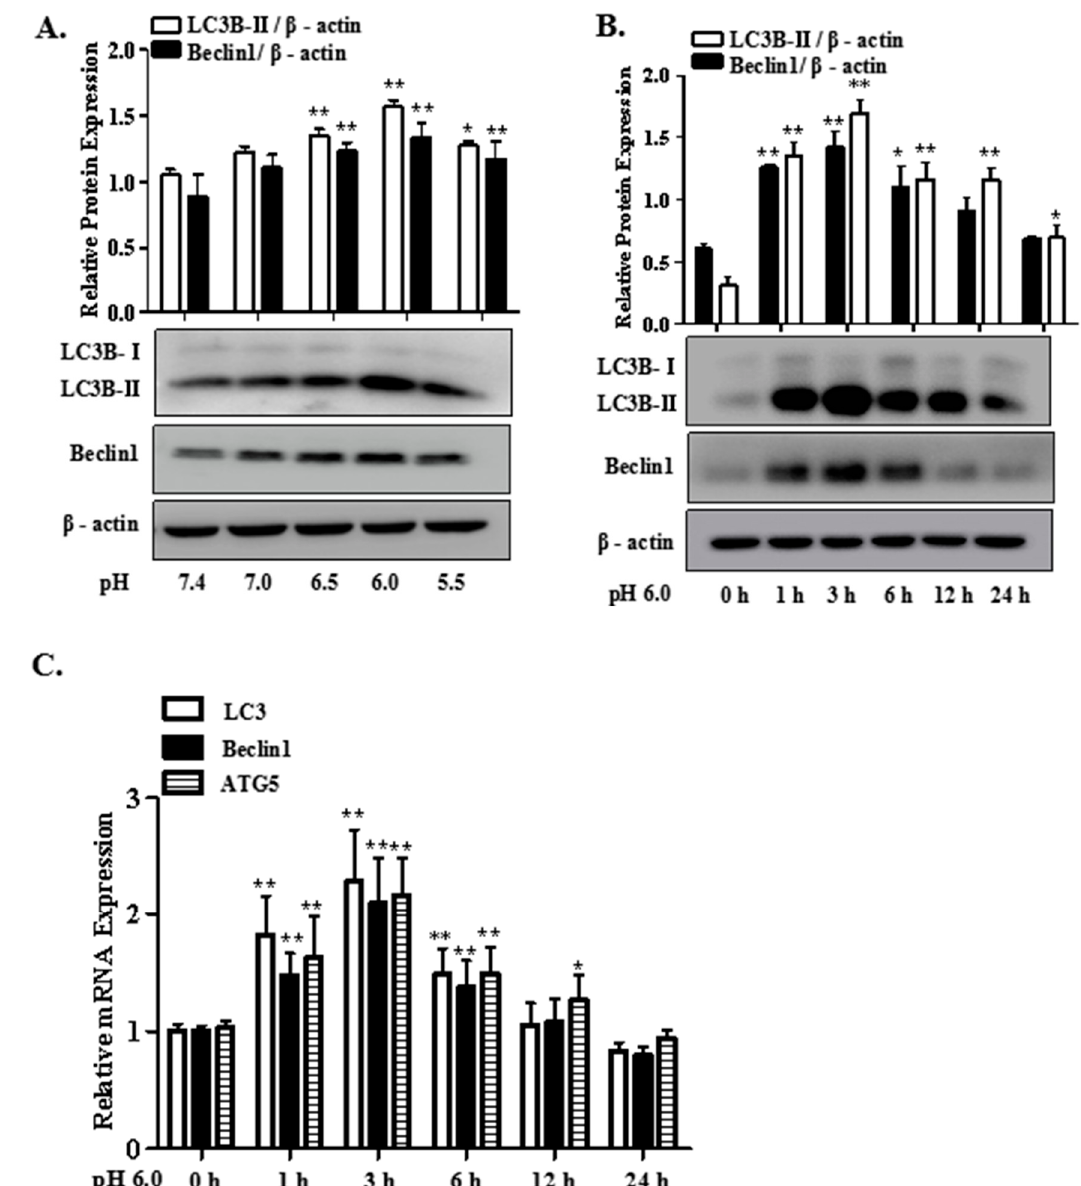
Figure 1. Extracellular acidification induces articular chondrocytes autophagy. ( A ) rat articular chondrocytes were treated with different concentrations of extracellular acid (pH 7.0, pH 6.5, pH 6.0, pH 5.5) for 24 h; ( B ) and ( C ) rat articular chondrocytes were treated with extracellular acid (pH 6.0) at different time points (1, 3, 6, 12 or 24 h). Then, the protein expression of LC3B-II and Beclin1 were assessed by Western blot; the mRNA expression of LC3, Beclin1 and ATG5 were analyzed by qRT-PCR. Values were presented as mean ± (Standard Deviation) SD of three independent experiments. * p < 0.05, ** p < 0.01 versus control group.